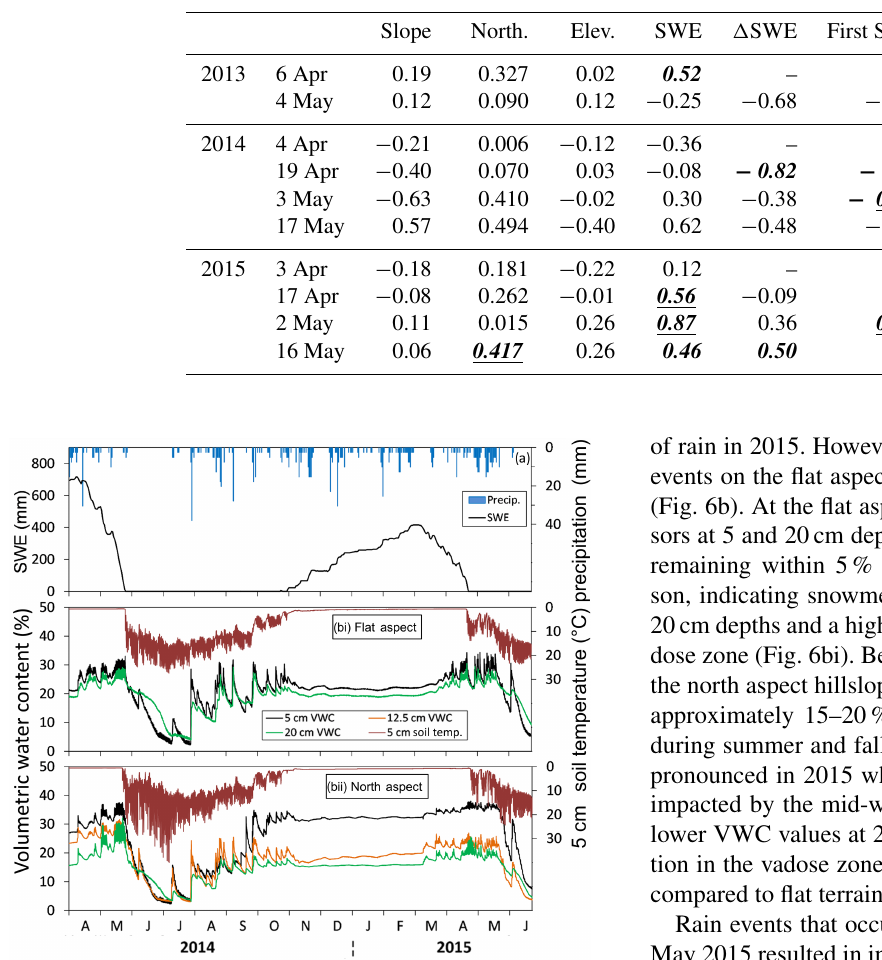
Figure 6. (a) Daily snow water equivalent (SWE) and precipitation recorded at the Dry Lake SNOTEL station and (b) the hourly soil volumetric water content (VWC) and 5cm deep temperature at (bi) the flat SNOTEL site and (bii) the installed sensors on the north aspect